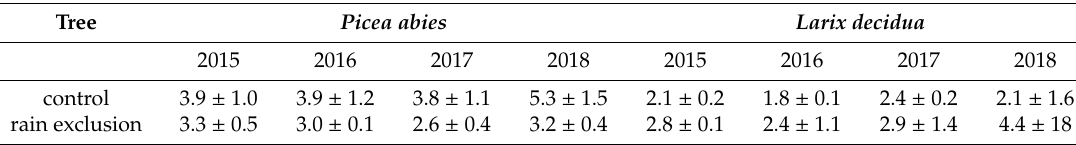
Table 4. Stem radial growth (mm) at the height of sensor installation of Picea abies and Larix decidua saplings in the year preceding the experiment (2015) and at the end of the study periods 2016, 2017, and 2018. Data are medians ± half total range of three saplings per treatment. No significant e ff ects of rain exclusion were